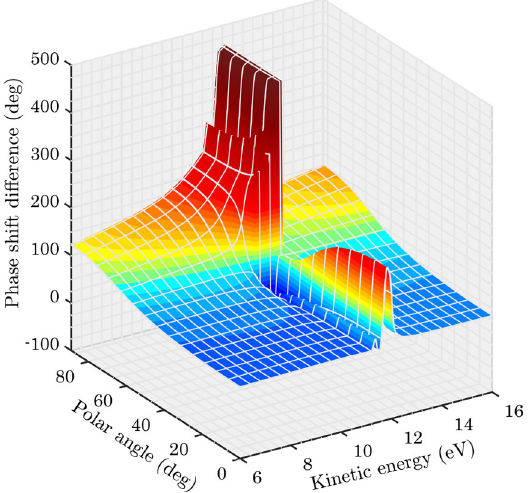
FIG. 3. Phase shift differences Δ ˜ η of two-photon ionization relative to single-photon ionization, calculated by perturbation theory, as a function of the polar angle θ and photoelectron kinetic energy. The large variation near 12.0 eV kinetic energy is due to the 2 p → 3 s